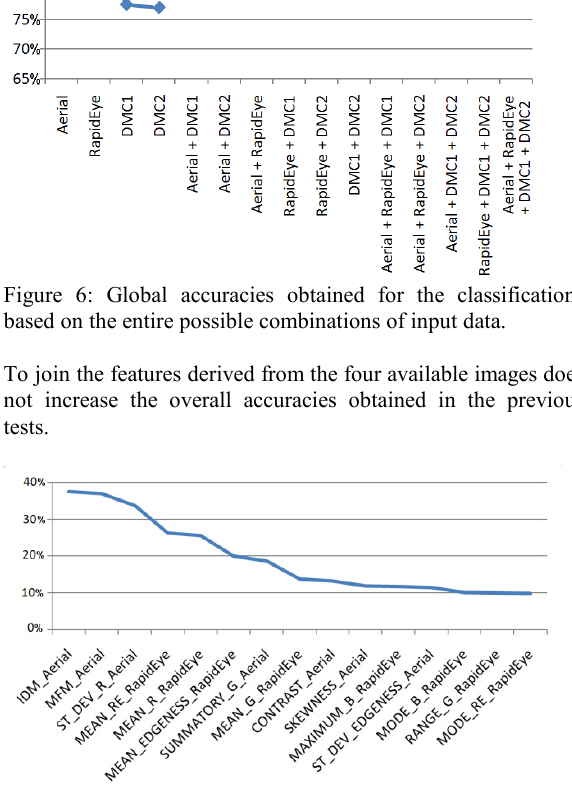
Figure 4: Relevance of features in classification of the first DMC image.